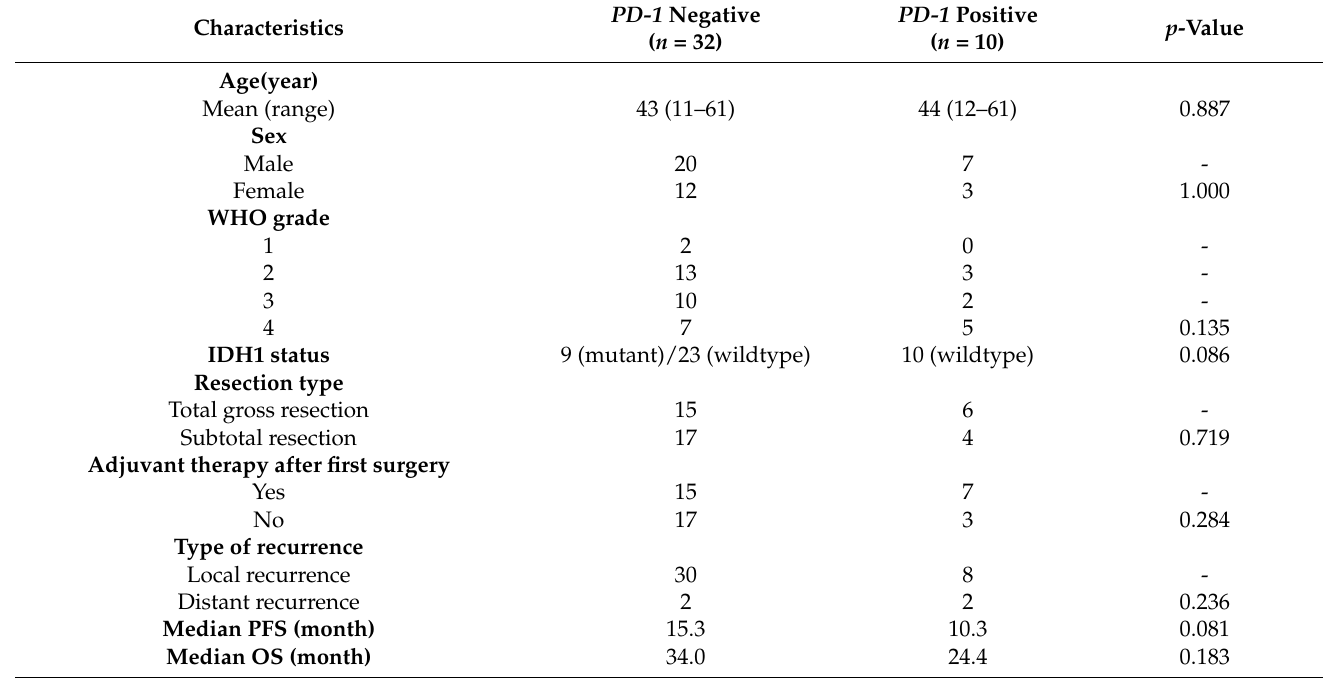
Table 3. Comparison of baseline clinical characteristics between PD-1 -negative and PD-1 -positive group in primary